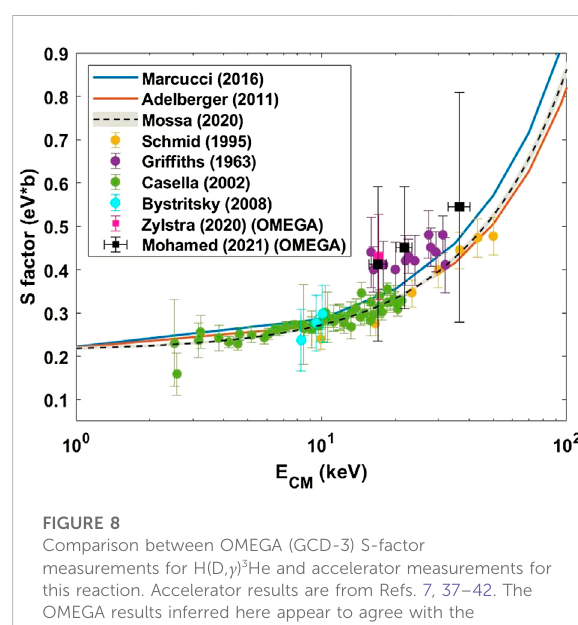
Comparison between OMEGA (GCD-3) S-factor measurements for H(D, γ ) 3 He and accelerator measurements for this reaction. Accelerator results are from Refs. 7, 37 – 42. The OMEGA results inferred here appear to agree with the accelerator results withinerrorbars,though theOMEGA errorbars are generally larger due to detection